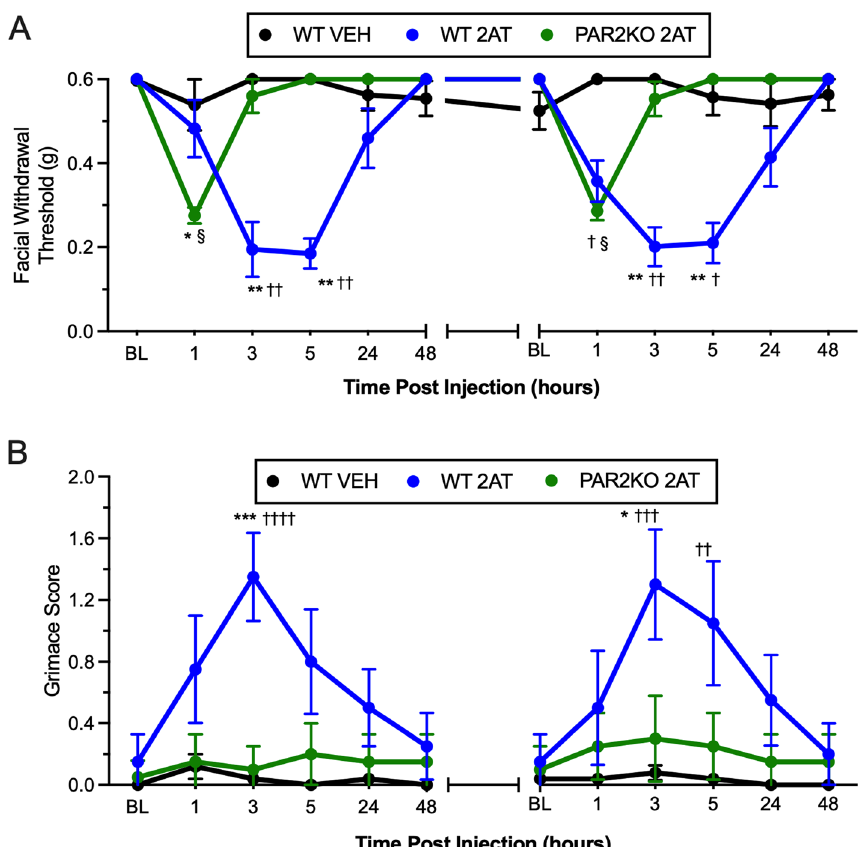
Fig. 3 Dural 2AT causes hyperalgesic priming to GTN . A Facial withdrawal thresholds in PAR2KO mice ( n 4) following treatment of 2AT, WT controls = following treatment of 2AT ( n 4), and WT controls ( n 4) following administration of vehicle and subthreshold GTN. Note that there are 12 days = = between the last time point of 48 h on the left and the baseline for GTN administration, indicated by the broken x-axis (see Fig. 1C). Application of 2AT significantly decreased withdrawal thresholds in WT mice and enhanced hyperalgesic priming to GTN compared to WT mice treated with vehicle (†) and PAR2KO mice treated with 2AT (*). PAR2KO mice previously treated with 2AT were hypersensitive at 1 h following dural 2AT and GTN administration compared to vehicle treated mice (§). B Grimace scores of PAR2KO mice and their WT controls. 2AT significantly increased grimacing in the acute phase in WT mice. *, † p < 0.05, **, †† p < 0.01, ***, ††† p < 0.001, †††† p < 0.0001. Data are represented as mean ±